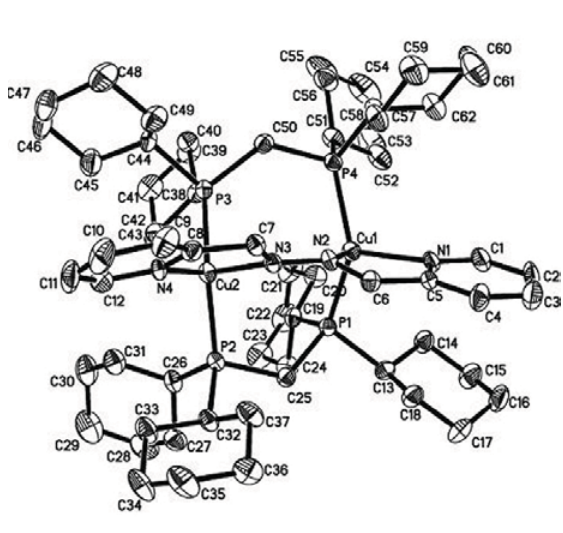
Figure 1. Molecular structure of the complex (ellipsoids shown at the 30% probability level).